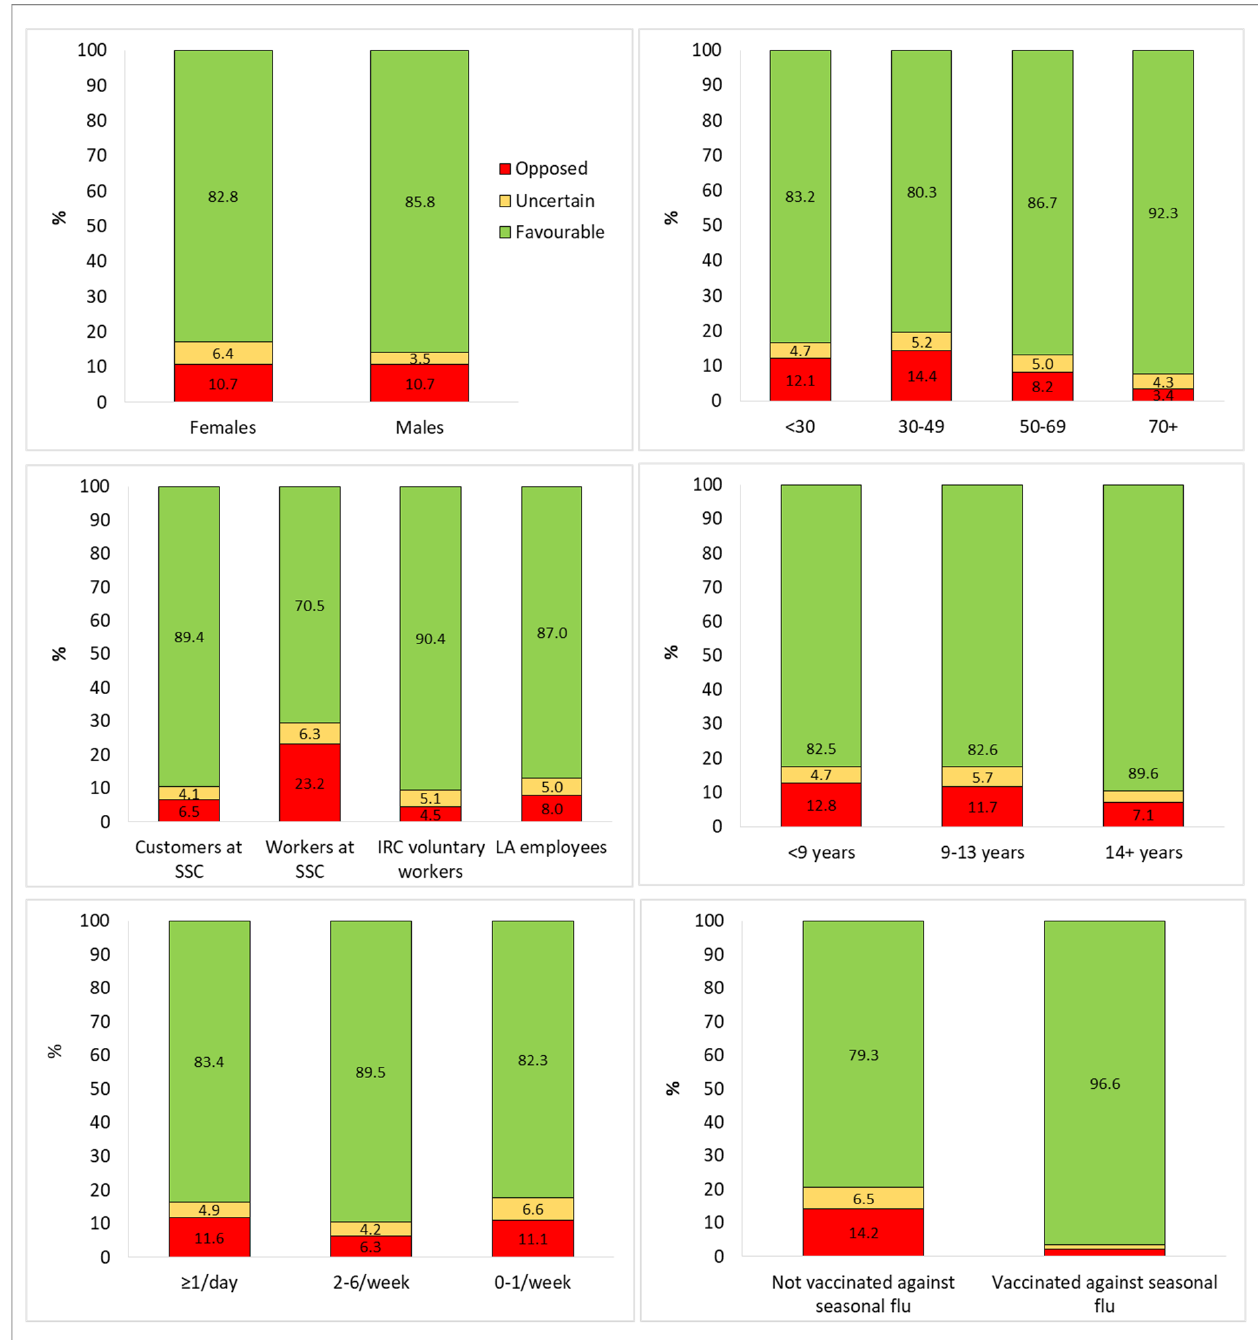
Figure 1. Propensity to be vaccinated against COVID-19, stratified by the main characteristics of the sample.